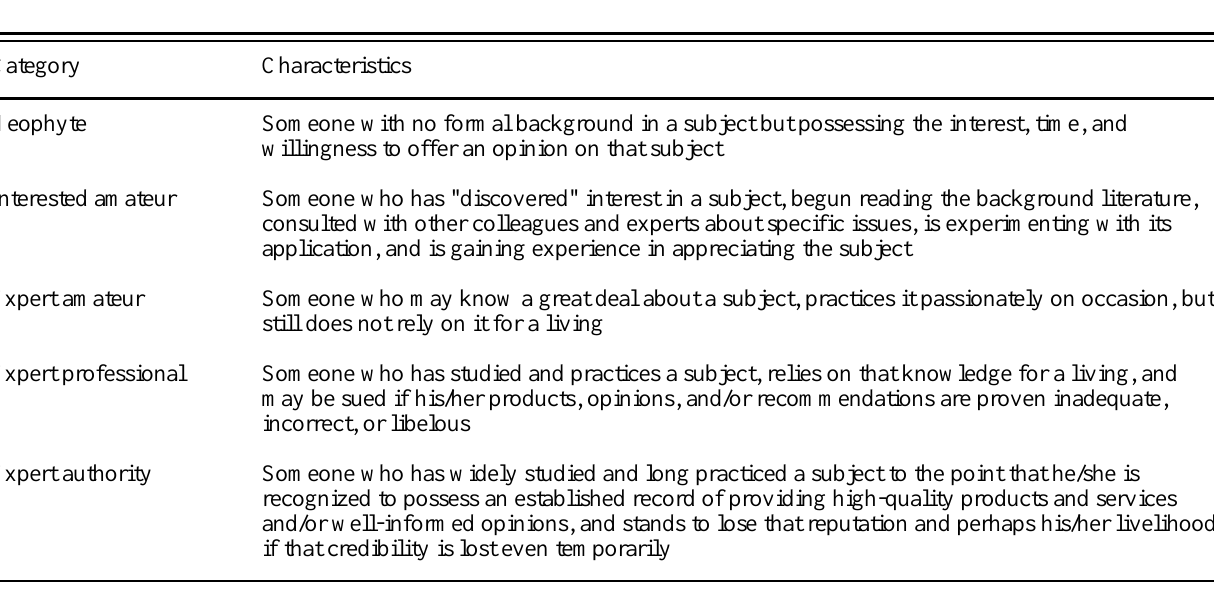
Table 1. A taxonomy of citizen sensors (taken from Coleman et al. 2009, 2010).